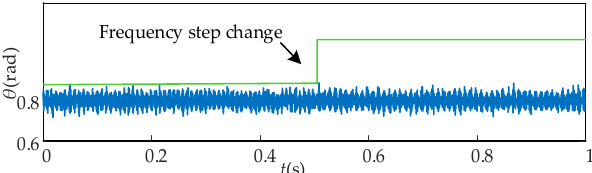
Figure 13. Phase simulation with the improved algorithm during frequency step change.